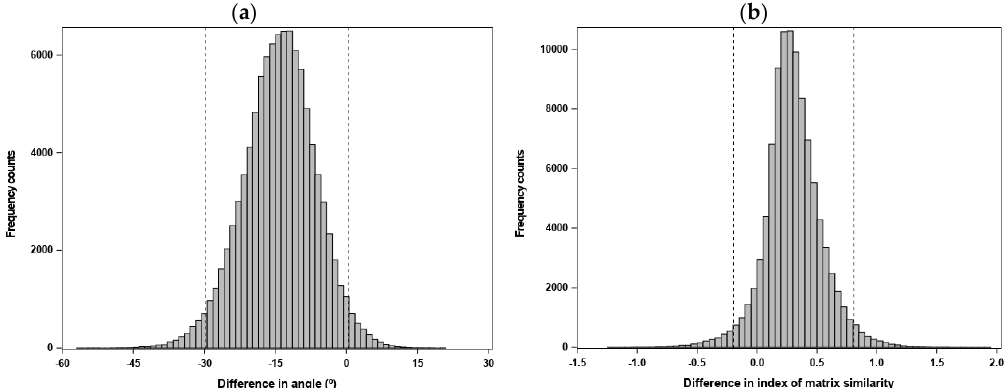
Figure 1. Simulated sampling distributions and 95% confidence intervals (depicted by the dashed vertical lines), obtained by the REML-MVN sampling approach [85], for the statistic Ψ m used to